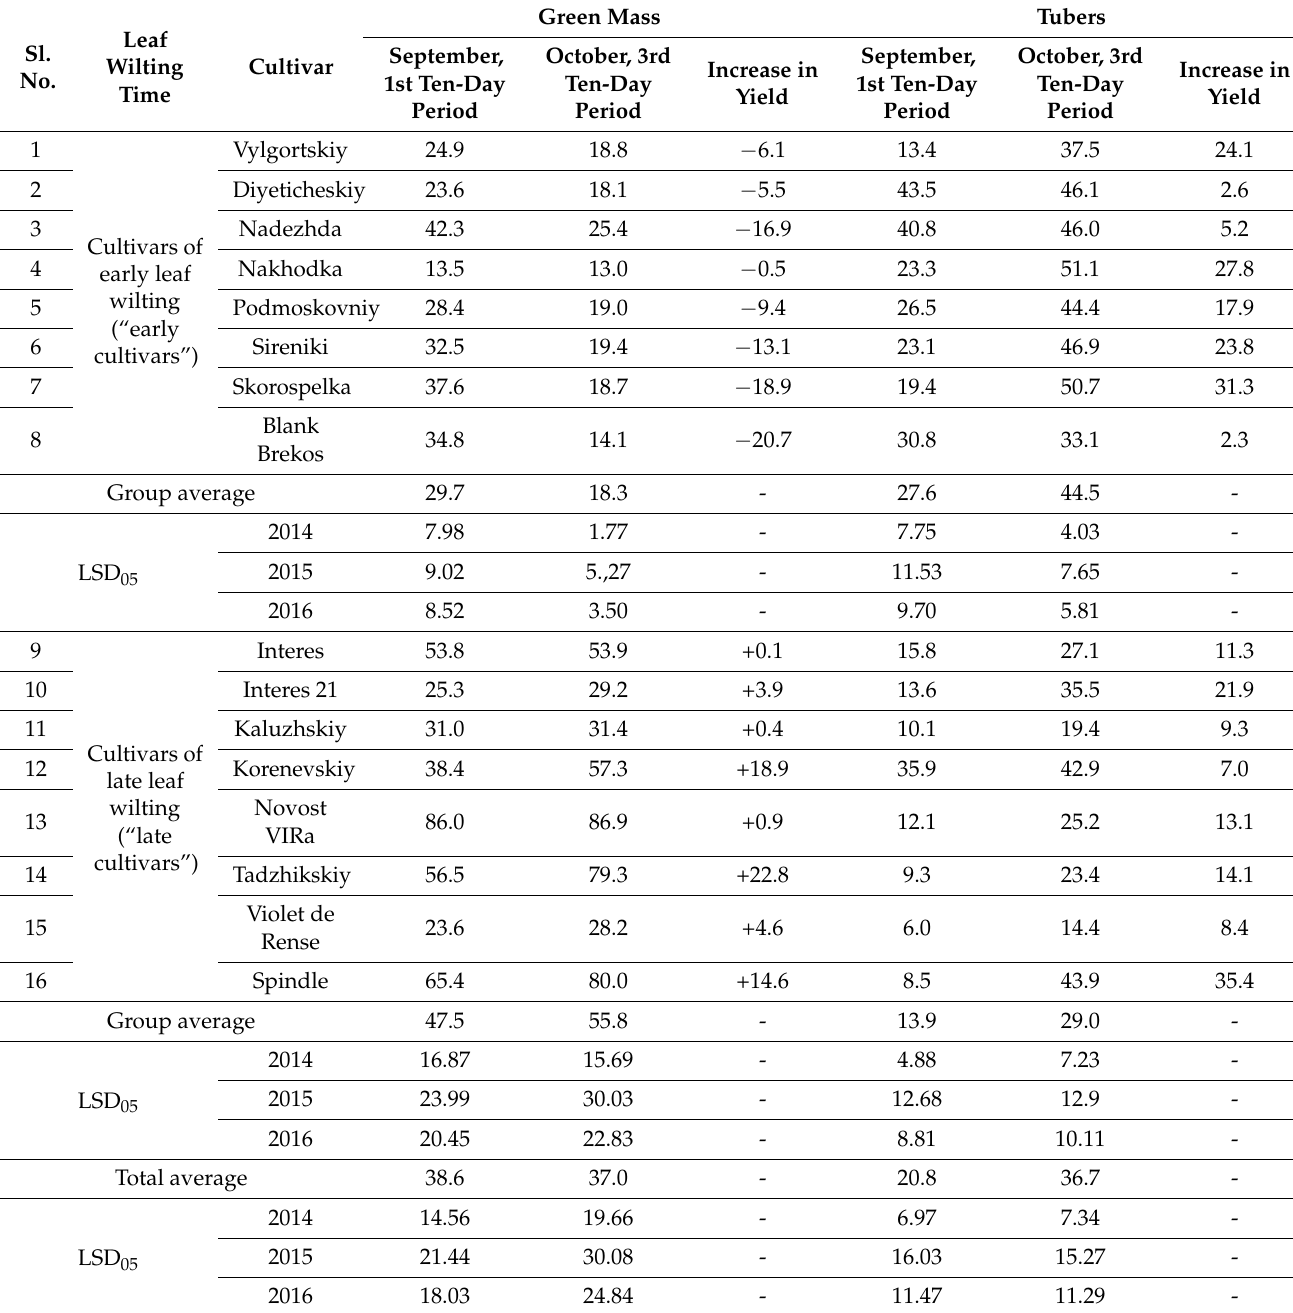
Table 2. Total yield of Jerusalem artichoke green mass and tubers,